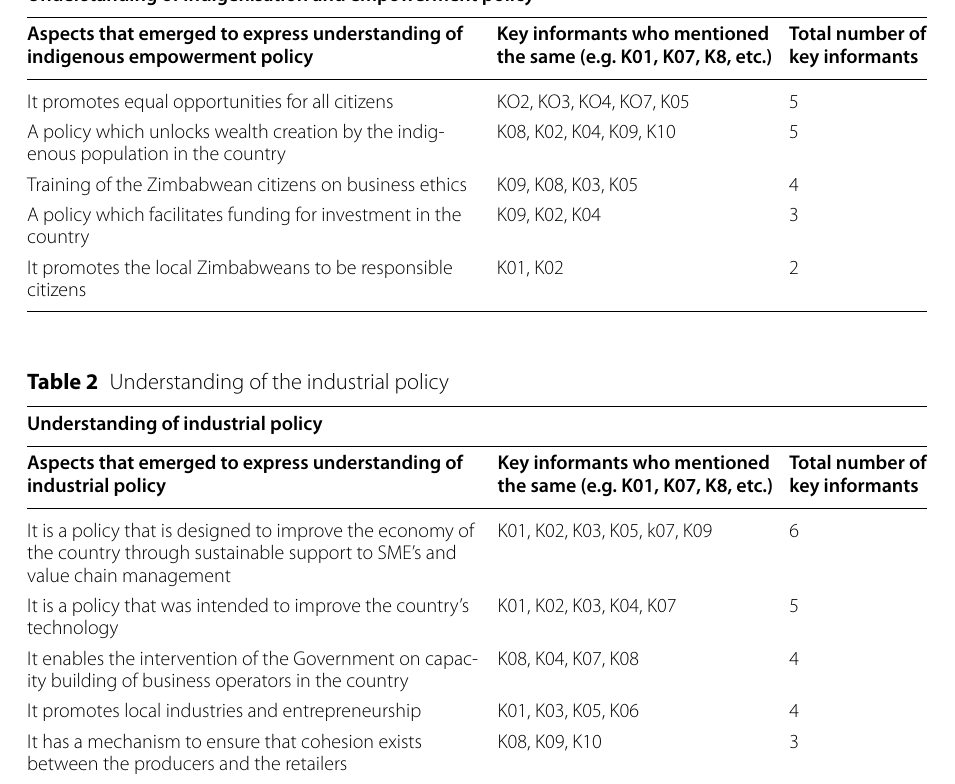
Table 1 Understanding of the indigenisation and empowerment policy n 10 = Understanding of indigenisation and empowerment policy